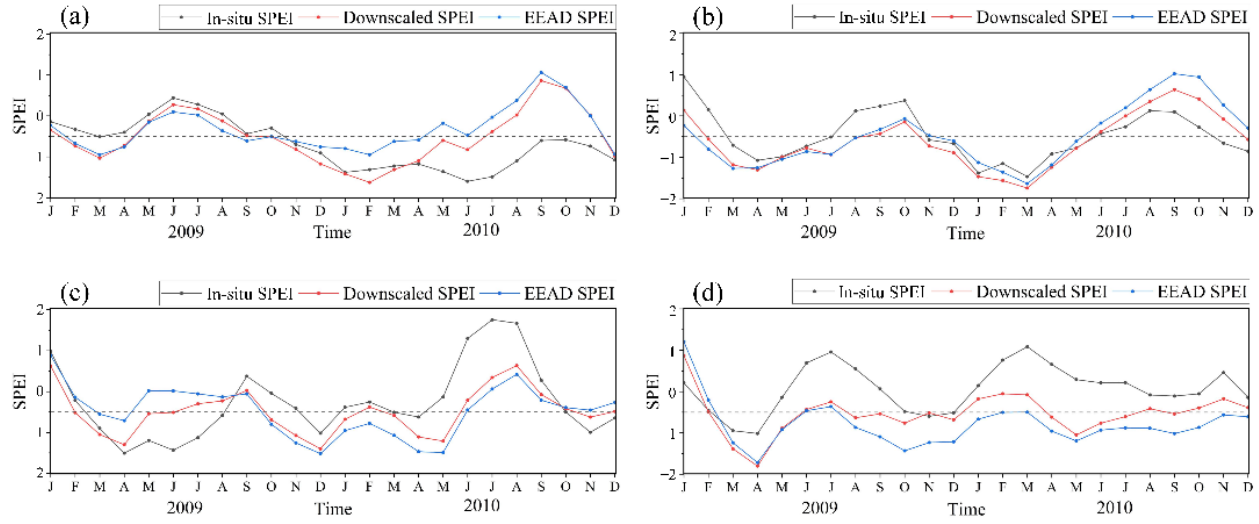
Figure 10. Time series of the in-situ SPEI, downscaled SPEI, and EEAD at the four selected meteor- ological stations. Panels ( a – d ) are site 1 – 4, respectively.